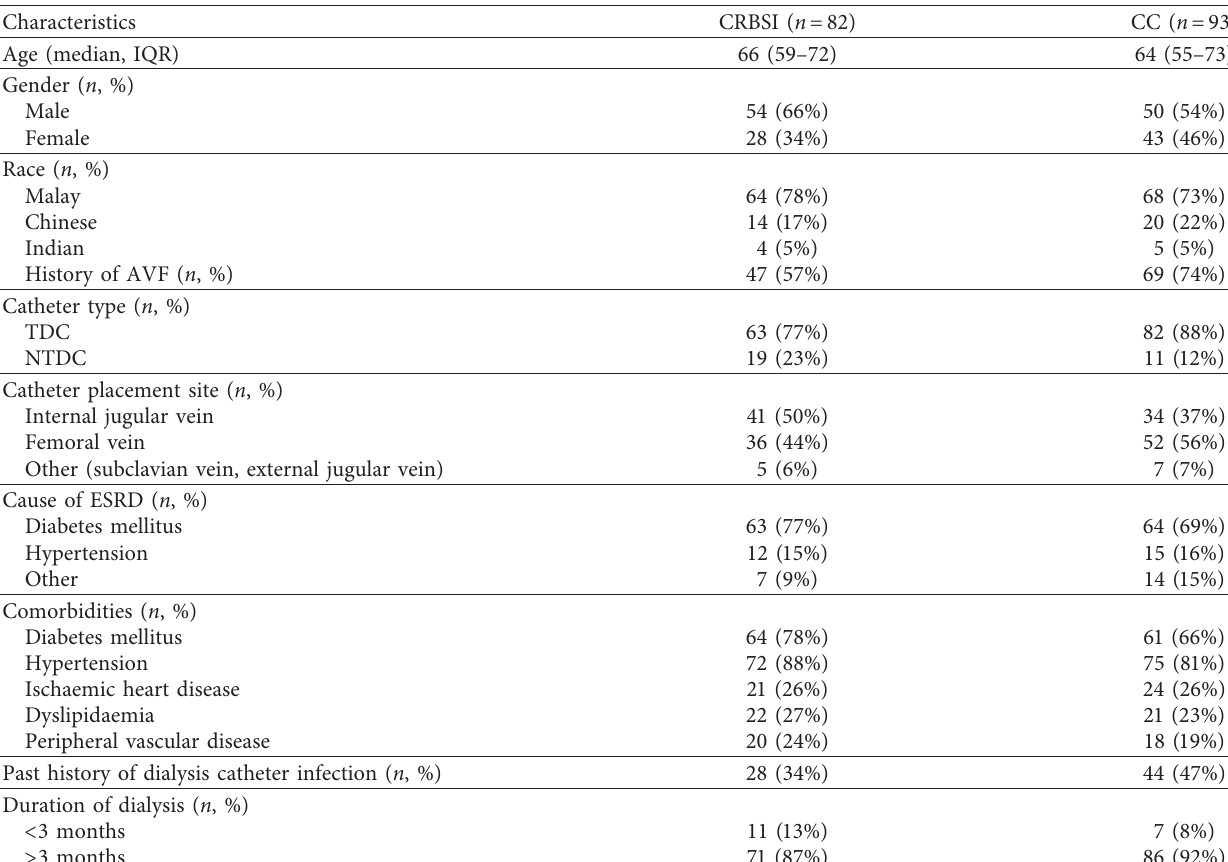
Figure 1: Study flow diagram. Table 1: Demographic characteristics of CRBSI and CC